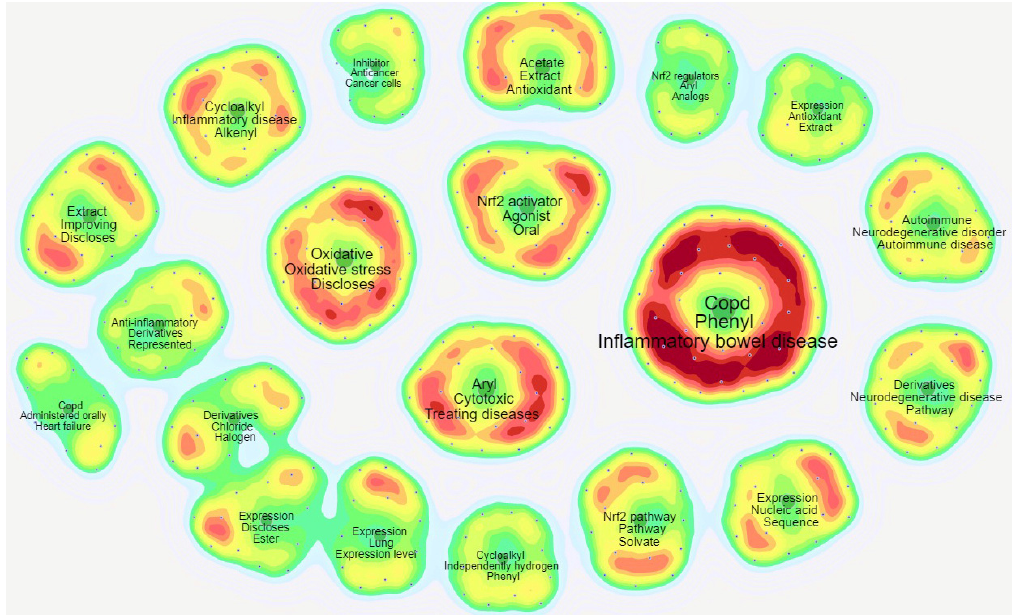
Figure 5. Top 20 themes emerging from Nrf2 patents published from January 2017 to May 2020 using the PatSeer Pro themes clustering tool (landscape mode). Each small dot represents a single patent. The gradient of colors from red to yellow to green indicates high, medium, or low co-occurrence, respectively, of the relevant themes in the specific group of patents.